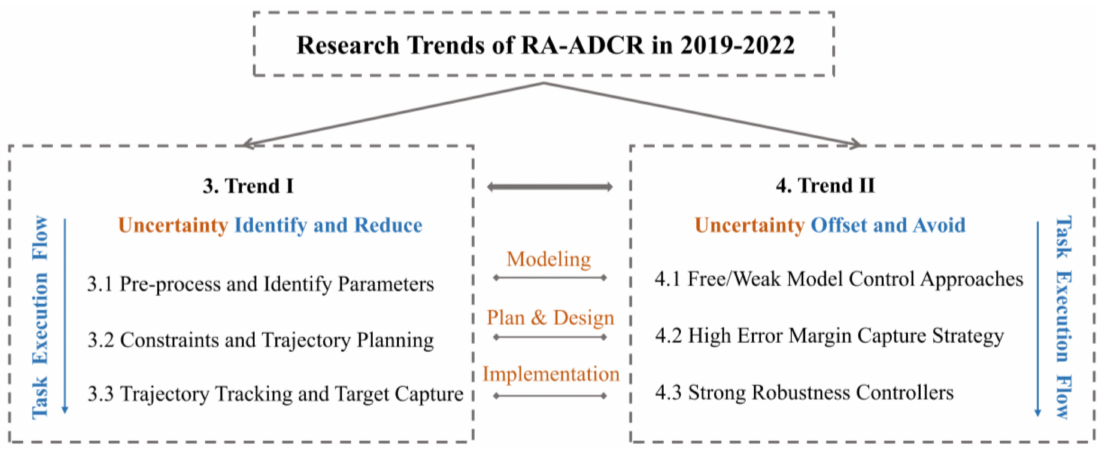
Figure 3. Research trends of RA-ADCR in